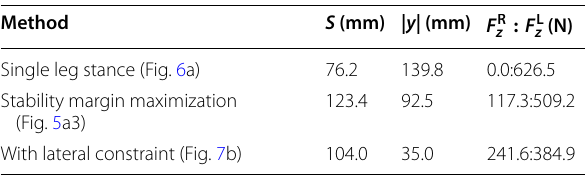
Table 1 Stability margin S , lateral amplitude | y |, and